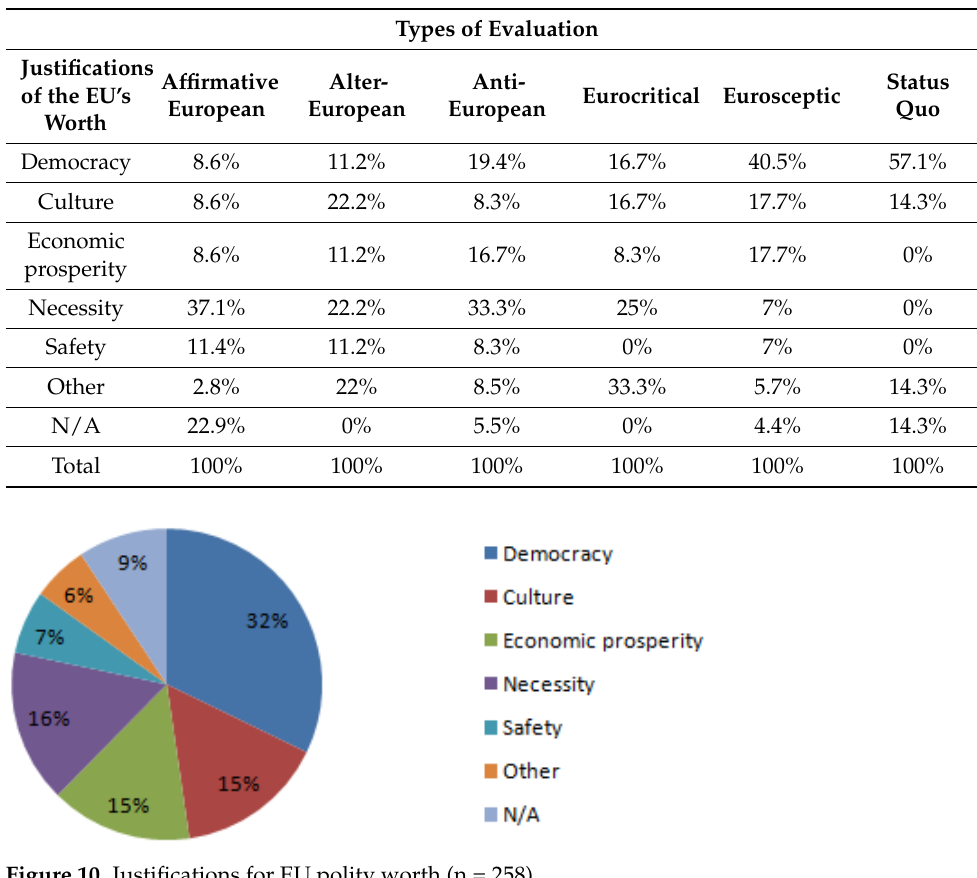
Figure 10. Justifications for EU polity worth (n = 258).